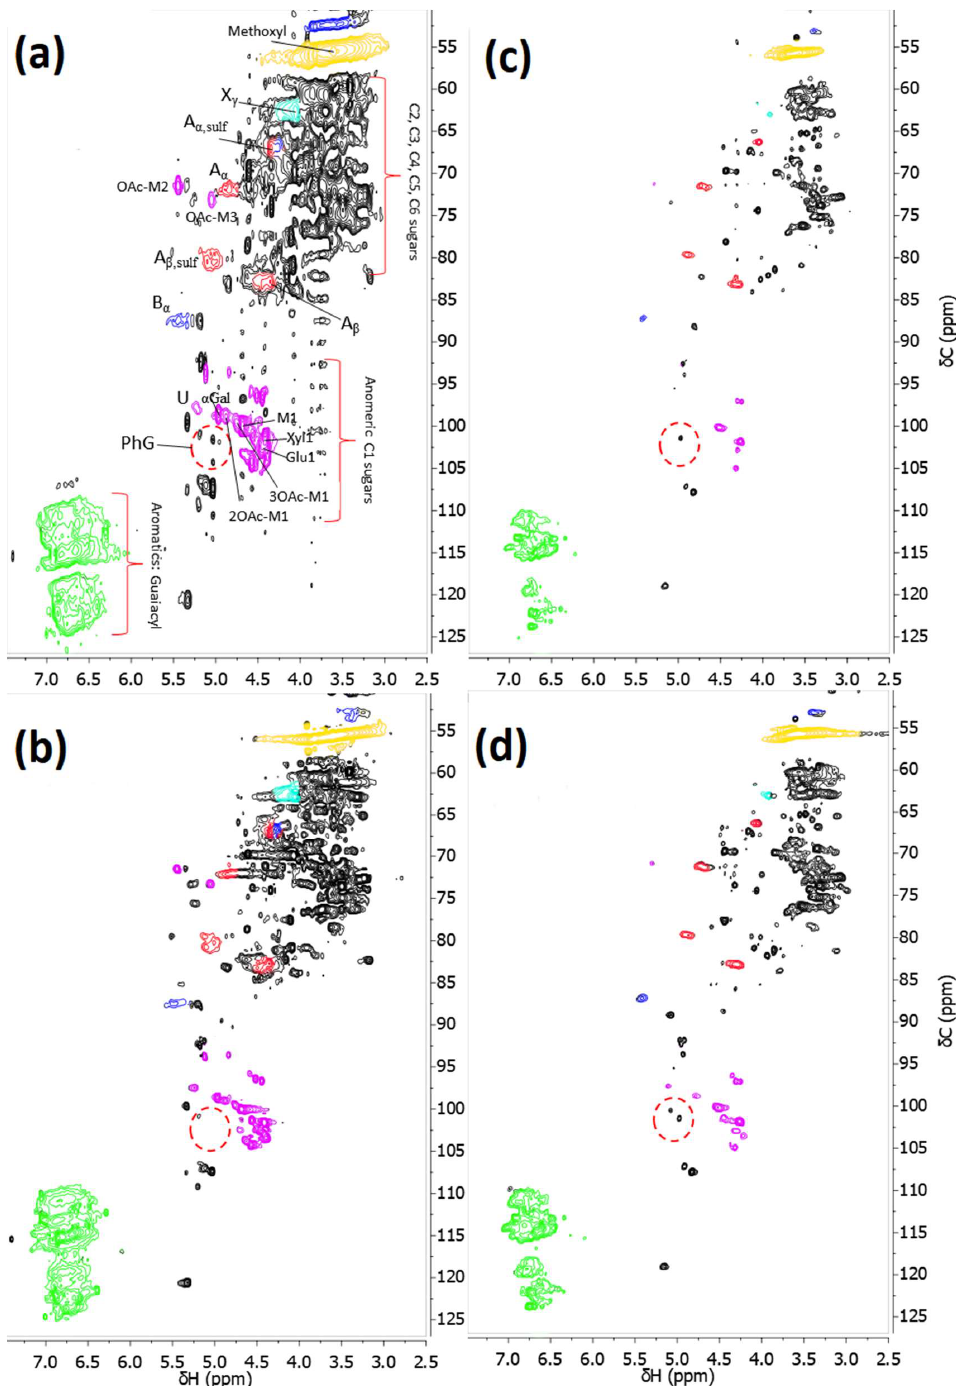
Figure 9. 2D HSQC NMR using D2O (spectrum A and B ) and a mixture of D2O and d6-DMSO (spectrum C and D ) as solvent. Spectrums A and C represent the RC70PP retentate while spectrums B and D represent the GR51PP retentate. The identified lignin bonds were: A x,y (B-aryl-ether bonds, red), B x,y (phenylcoumaran, blue), X γ (cinnamyl alcohol, light blue), PhG (phenyl glycosidic LCC bonds, red circle) and the aromatics in the guaiacyl units (green). The identified polysaccharides and uronic acids (purple) were: MX (mannopyranose), XOAc-MX (O-acetylated mannopyranose), XylX (xylopyranose), GluX (glucopyranose), α-Gal (galactopyranose), and U (glucuronic acid). The notations x and y are the x-carbon and sulfonation respectively.